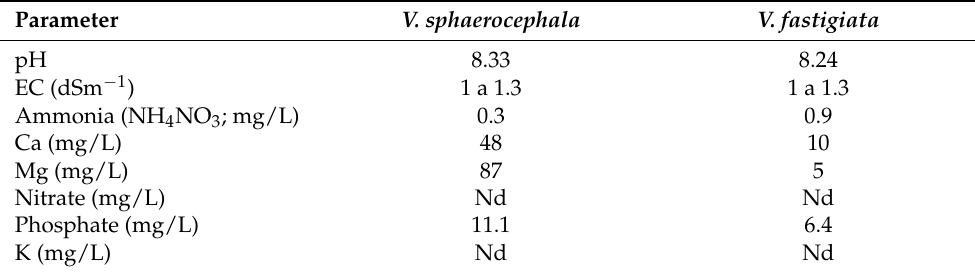
Table 1. Chemical properties of the aqueous extracts of Verbesina sphaerocephala and Verbesina fastigiata . Parameter V. sphaerocephala V. fastigiata 8.33